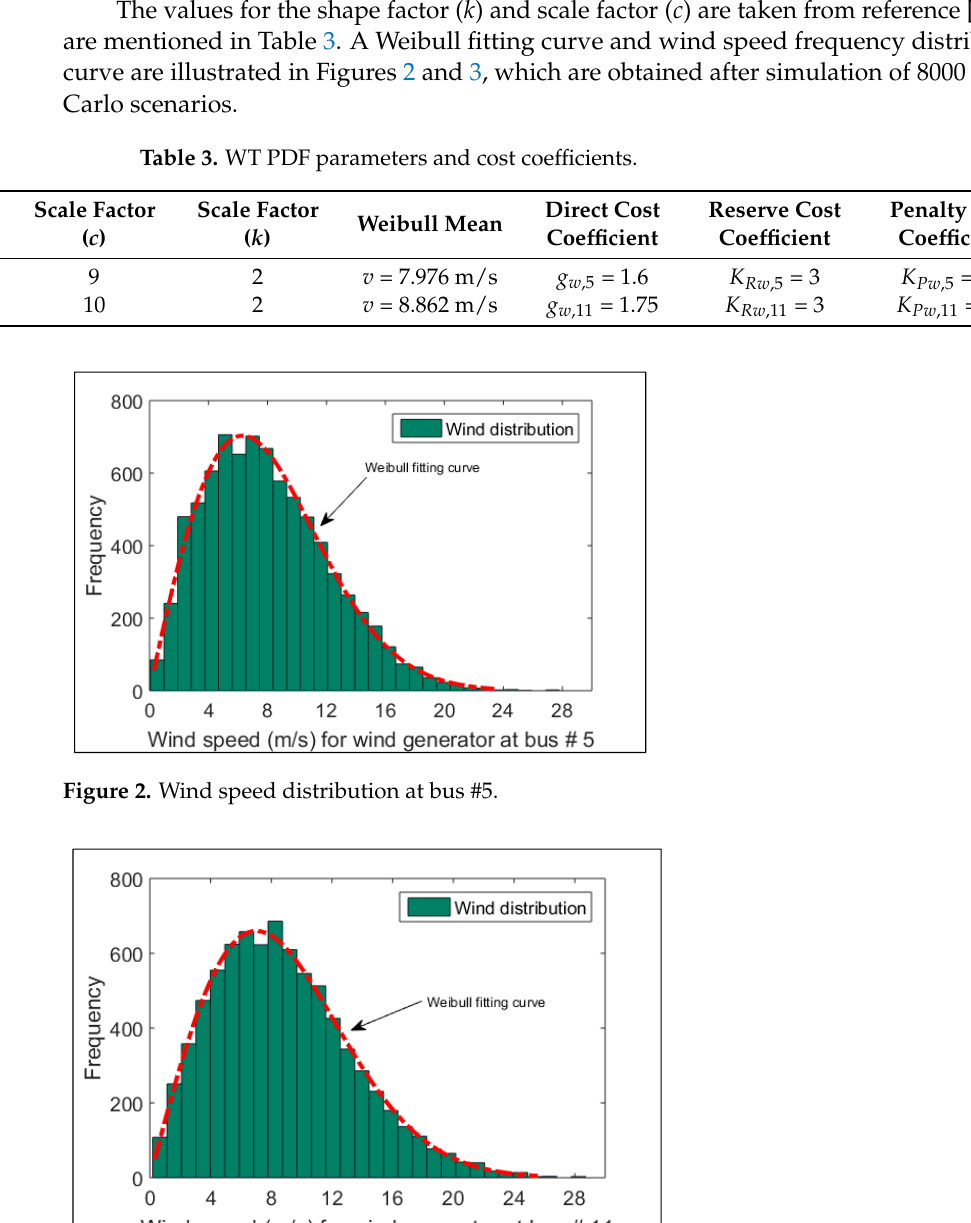
Figure 4. Distribution of solar irradiance at bus #13. Figure 5. Distribution of SPV real power at bus #13.